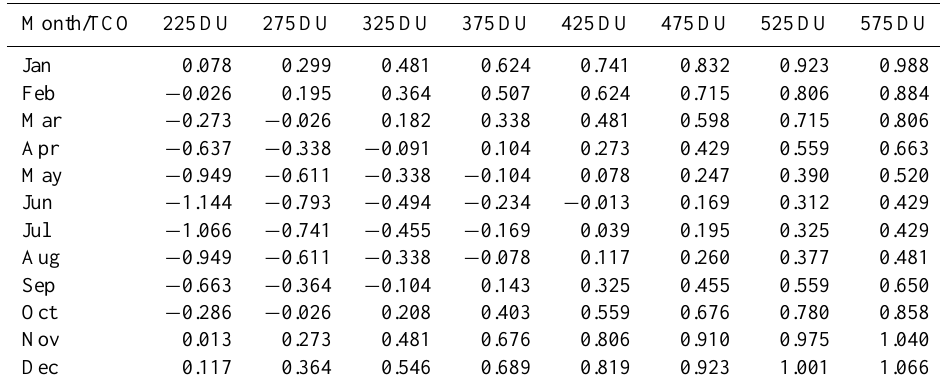
Table 3. Dobson TCO correction in percent as a function of month and ozone amount for 40 ◦ N.